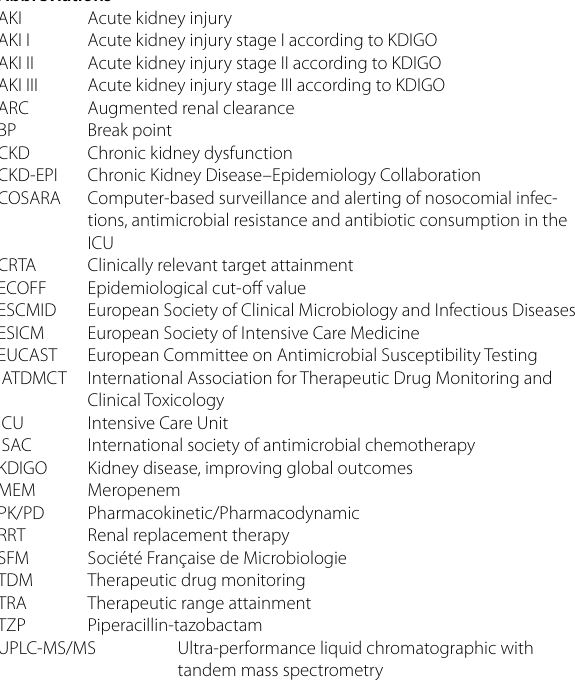
Additional file1: Table S1 . Distribution of infection foci as a percentage of total infections treated. Table S2 . Top 10 most frequently identified pathogens. Table S3 . Clinical characteristics of the collected samples [counts and]. Table S4 . Evaluation of dosing appropriateness [count and]. Table S5 . Evaluation of dosing appropriateness according to AKI stage on sampling day [counts and]. Figure S1 . Percentage of CRTA for all TZP samples according to renal function and BP multiplication targeted. Figure S2 . Percentage of CRTA for TZP steady state samples according to renal function and BP multiplication targeted. Figure S3 . Percentage of CRTA for TZP non-steady state samples according to renal function and BP multiplication targeted. Figure S4 . Percentage of all TZP samples within the therapeutic range for different BP multiplications according to the BP and renal function. Figure S5 . Percentage of steady state TZP samples within the therapeutic range for different BP multiplications according